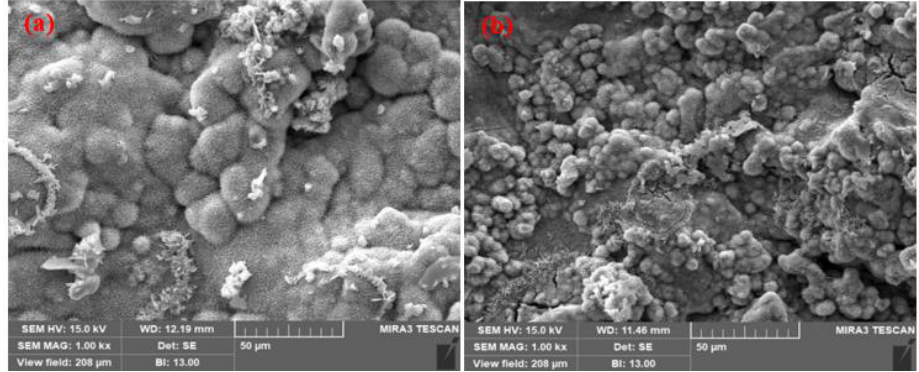
Figure 11. SEM images of corrosion products at 1000× formed on the zinc coatings deposited by the ( a ) arc thermal spray and ( b ) plasma arc thermal spray processes after 23 d of exposure to artificial seawater.